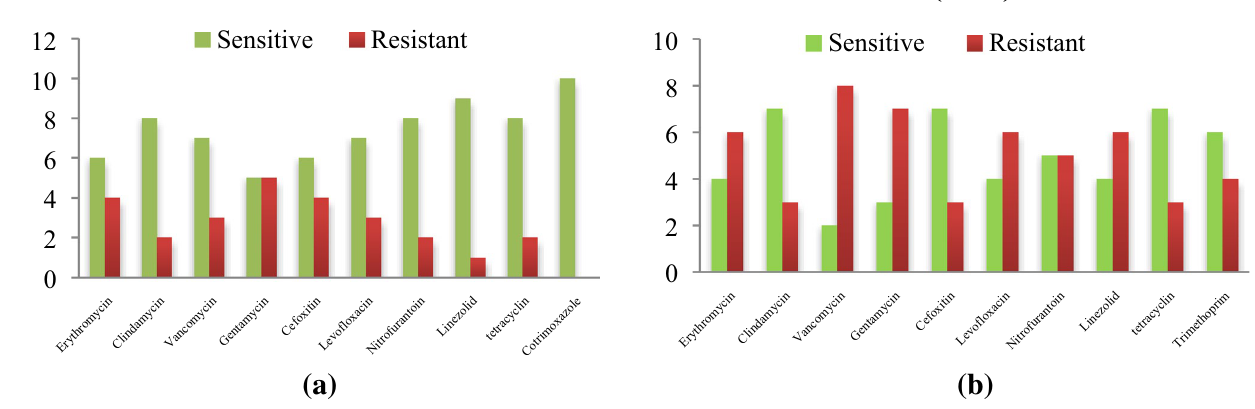
Figure 1. ( a ) Antibiogram of S. aureus isolated from instruments in PICU. ( b ) Antibiogram of CoNS and S.aureus isolated from instruments in PICU. CoNS a re highly sensitive to cotrimoxazole (10/10) followed by linezolid (9/12) while S.aureus shows a higher sensitivity to tetracycline (8/10) and vancomycin (8/10).